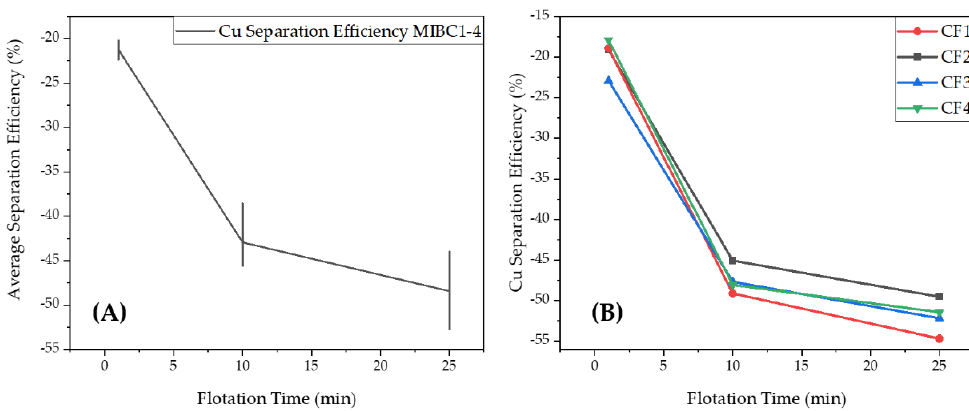
Figure 5. The separation efficiency values for Cu in the ( A ) MIBC experiments and ( B ) CellFroth experiments.